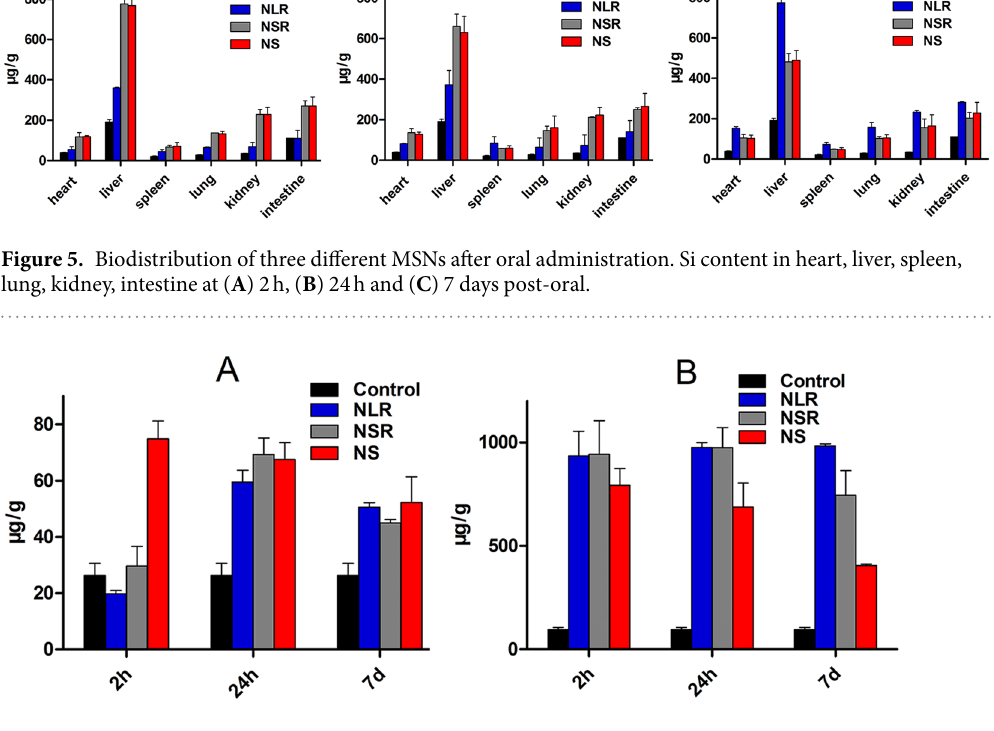
Figure 6. Excretion of three different MSNs after oral administration. Si contents in urine ( A ), feces ( B ) at different time